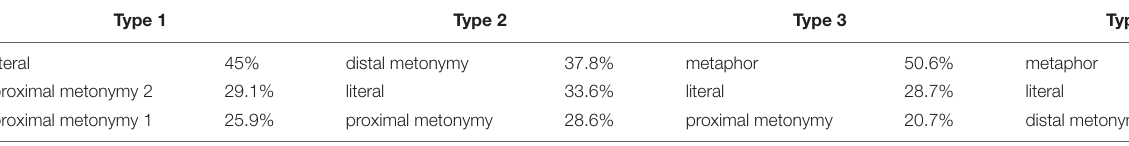
TABLE 2 | Proportion of correct classification for each of the three senses in each Type (each Type = 100%).